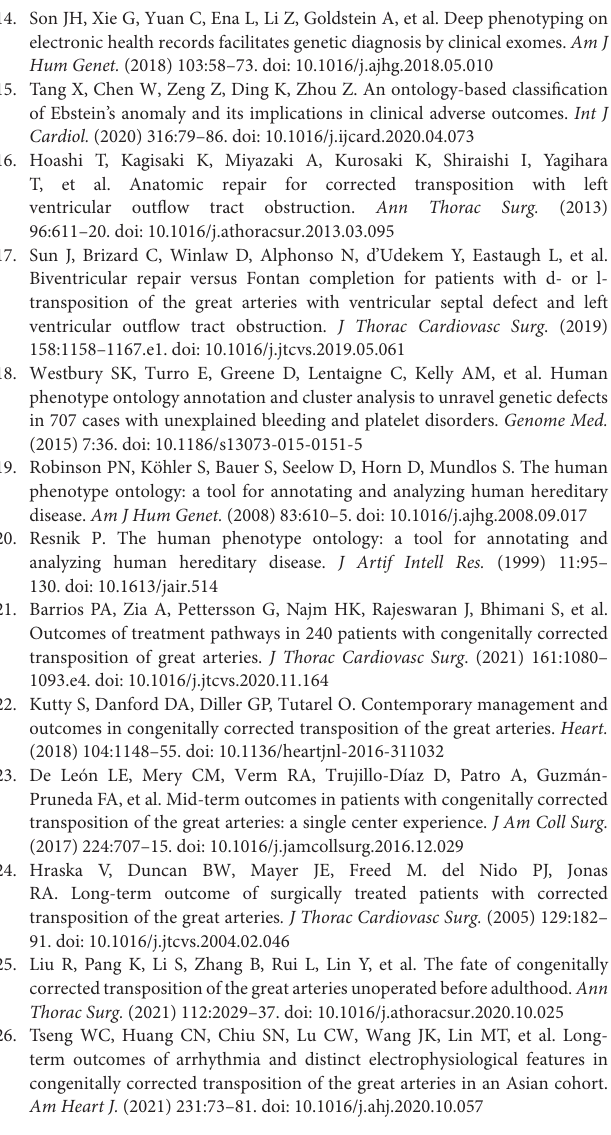
Supplementary Figure 4 | Kaplan-Meier analysis of three surgical strategies. (A) The comparison of survival rate among three surgical strategies ( p = 0.18); (B) Freedom from composite endpoints among three surgical strategies ( p = 0.35). Shading indicates a 95% CI. Supplementary Figure 5 | Reintervention rate of three surgical strategies. (A) Freedom from reintervention among three surgical strategies ( p = 0.0015); (B) Effects of different surgical strategies on reintervention in patients of cluster 2 ( p = 0.039). Shading indicates a 95% CI. Supplementary Figure 6 | Kaplan-Meier analysis of different surgical strategies in cluster 1 and cluster 3. (A) Freedom from reintervention of different surgical